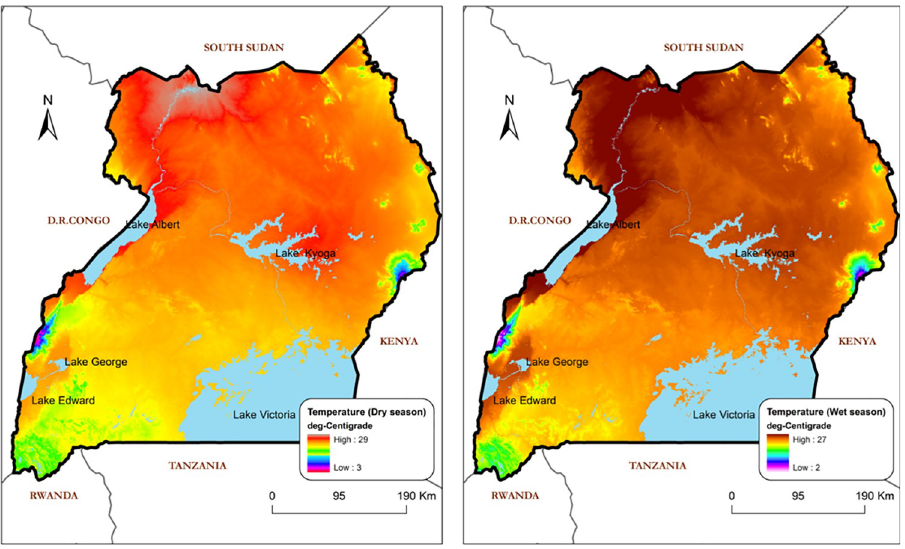
Fig 5. Temperature Index as predictor variable for the model. This temperature map was processed using ArcGIS 9.1 based on data obtained from